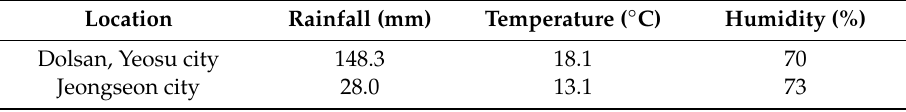
Table 1. Environmental conditions 1 for the Brassica juncea used in the